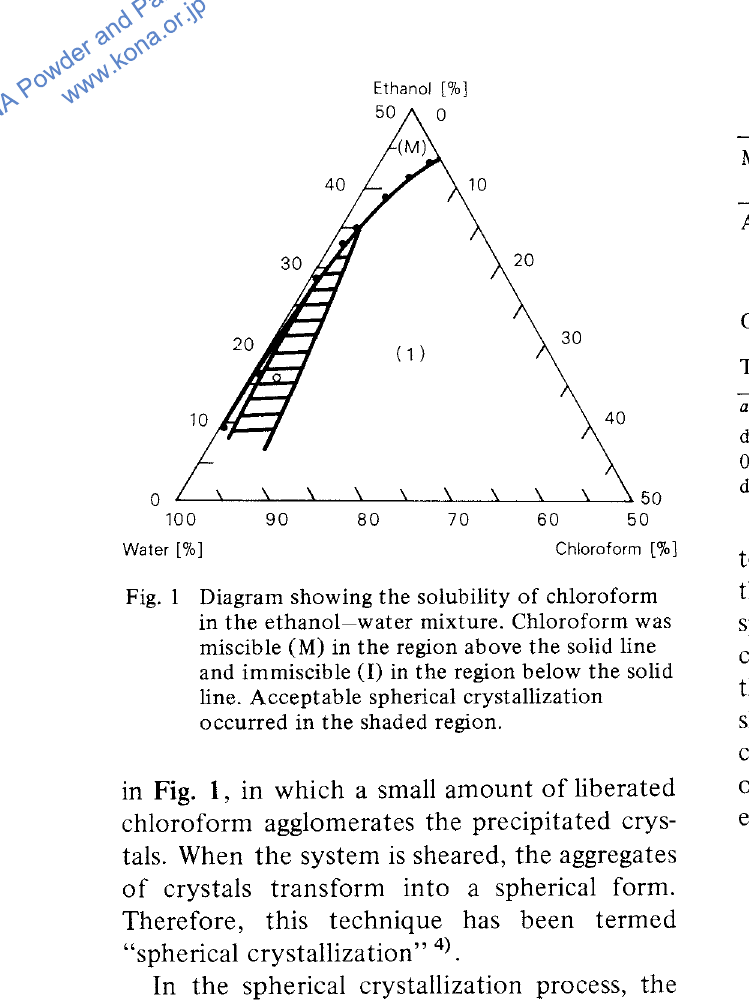
Table 1 Micromeritic properties of primary crystals and agglomerates Micromeritic